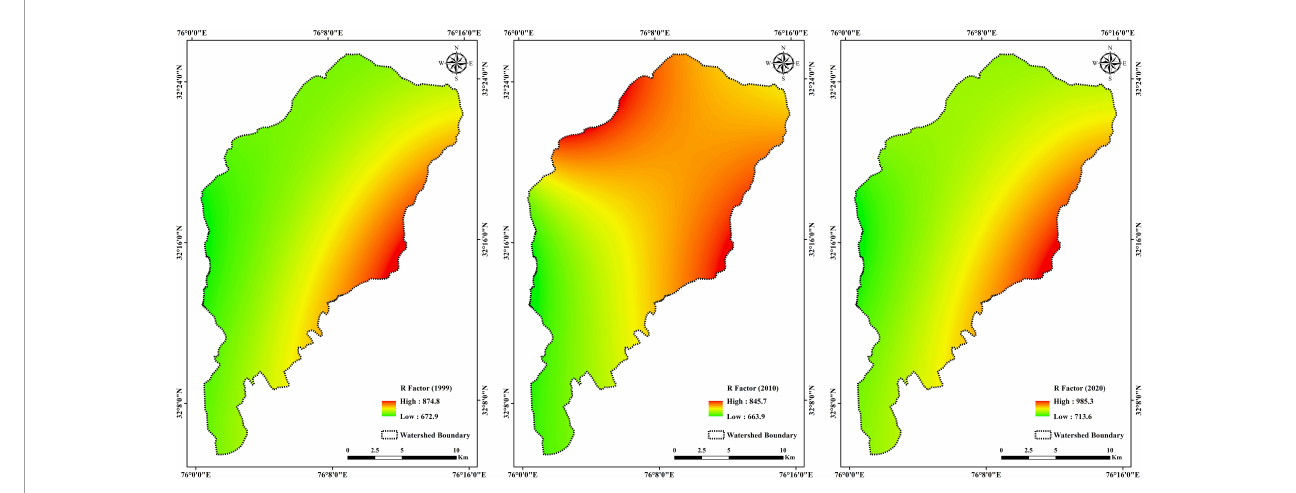
FIGURE9 Maps showing R factor for the years 1999, 2010, and 2020 of the Dehar watershed.